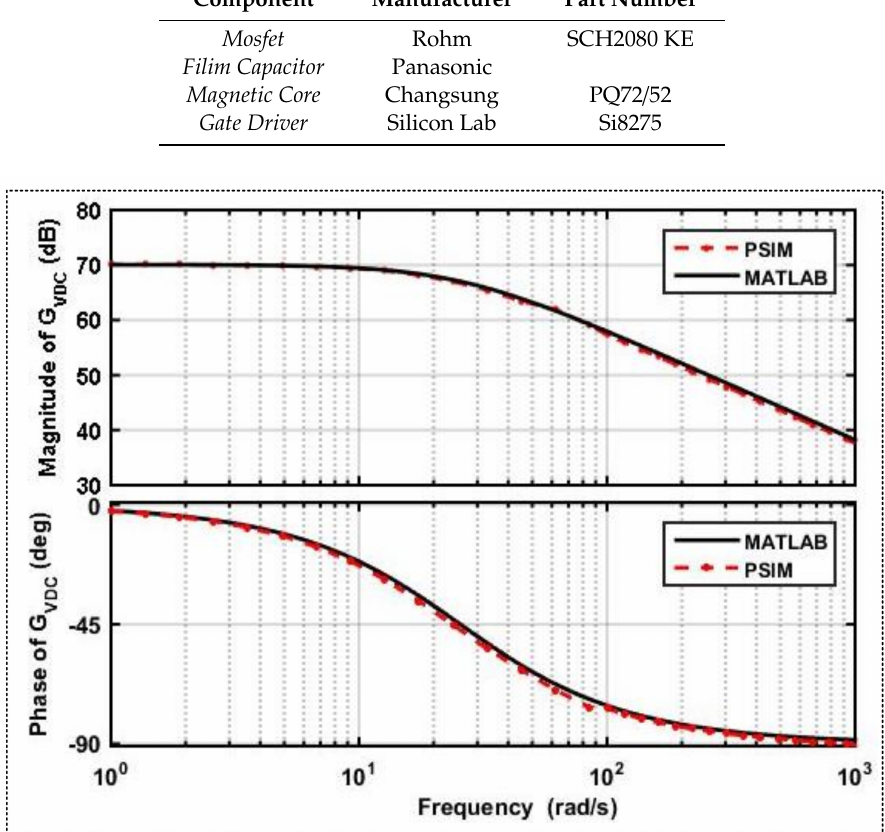
Figure 6. Comparison of Bode plots of a DAB converter drawn by MATLAB and